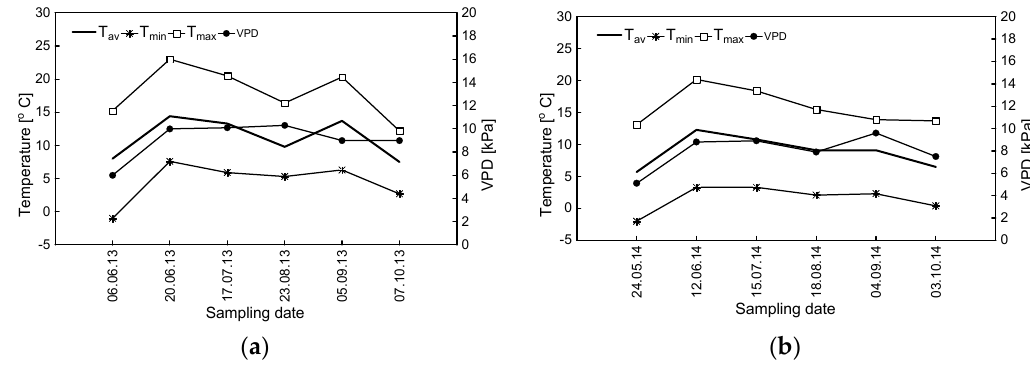
Figure 1. Variability of air temperatures: Average (T av ), minimum (T min ), maximum (T max ), and vapor pressure deficit (VPD) over the sampling season of 2013 ( a ) and 2014 ( b ).